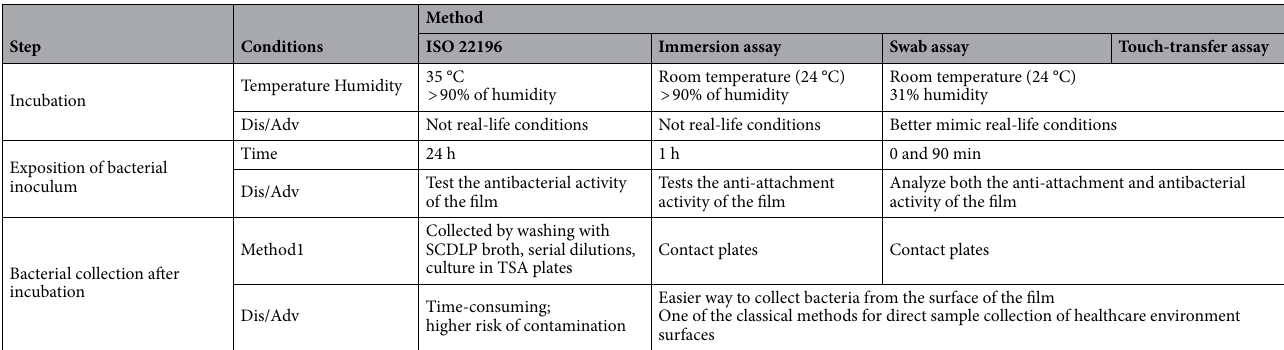
Table 1. Comparison of the conditions and advantages/disadvantages of the four methods studied to test the antimicrobial activity of highly hydrophobic surfaces. Dis/Adv disadvantages/advantages, SCDLP